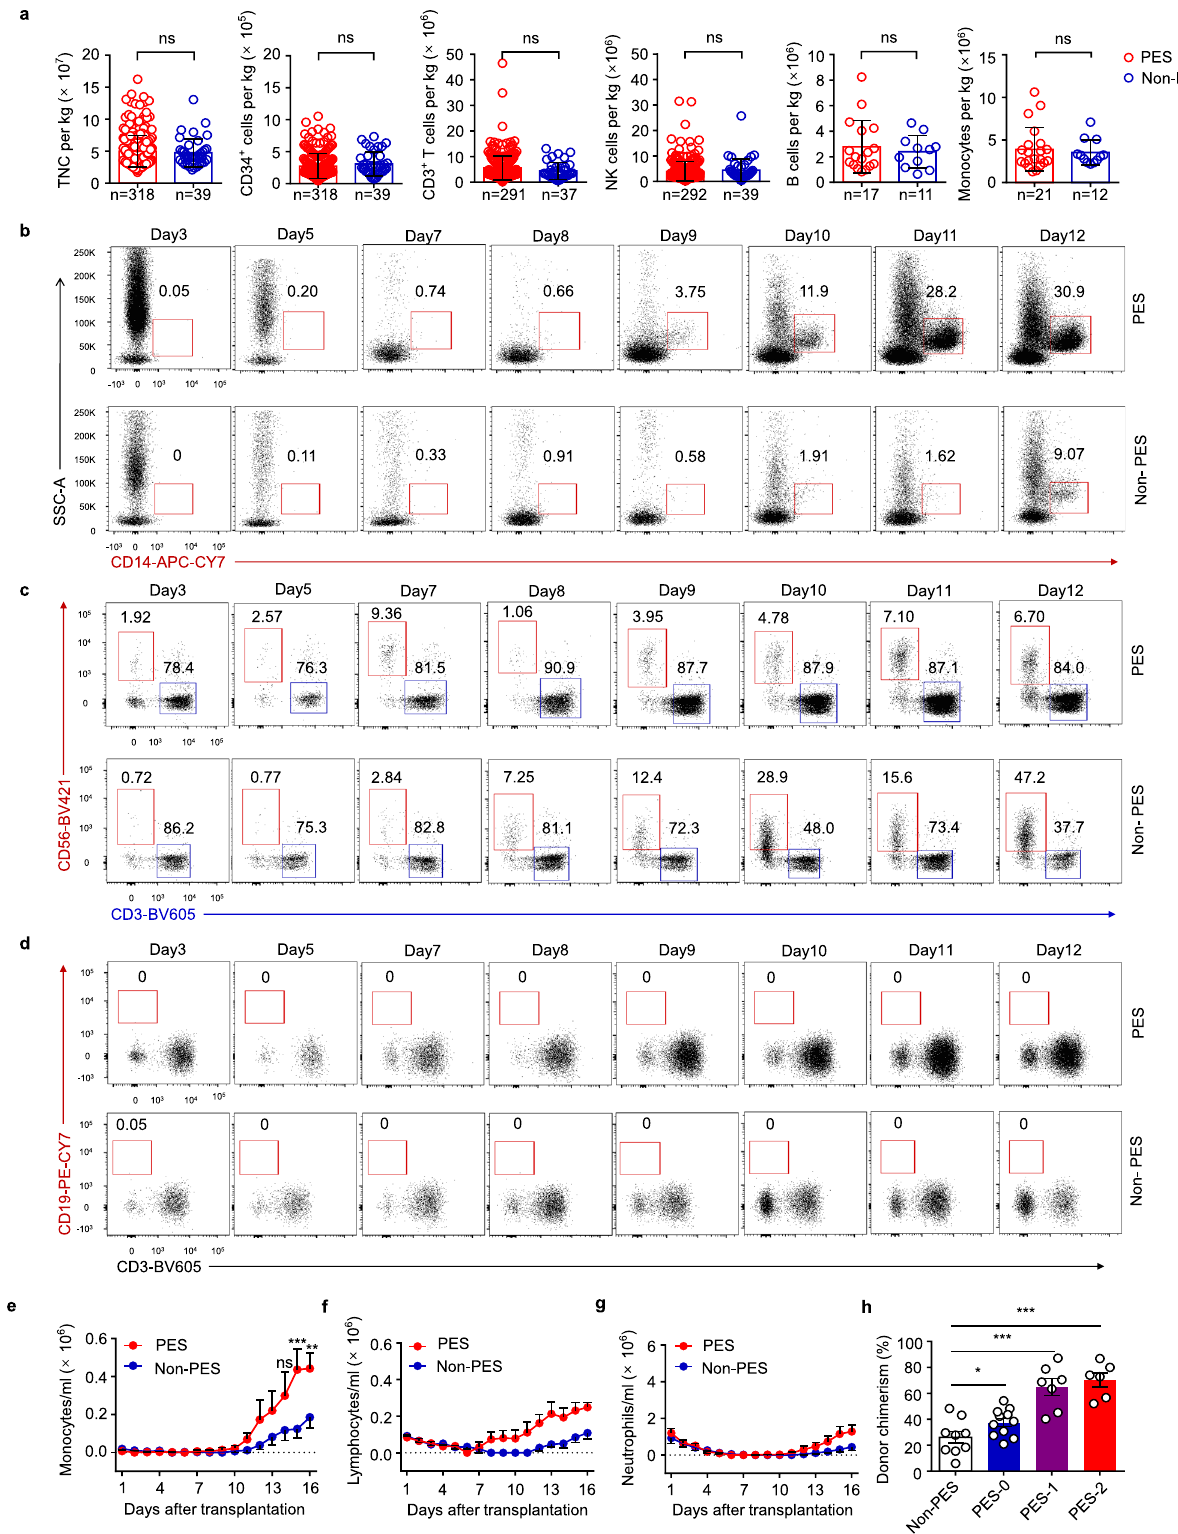
derived from peripheral blood stem cells (Fig. 3g). Intracellular staining results further highlighted a signi fi cant increase in IL-6 and TNF- α in monocytes derived from human cord blood, but not in T cells, NK cells, or B cells (Fig. 3h, i, Supplementary Fig. 2b, Supplementary Fig. 4a, b). Monocytes, T cells, NK cells and B cells did not express IFN- γ , IL-1 β , and IL-17A in either